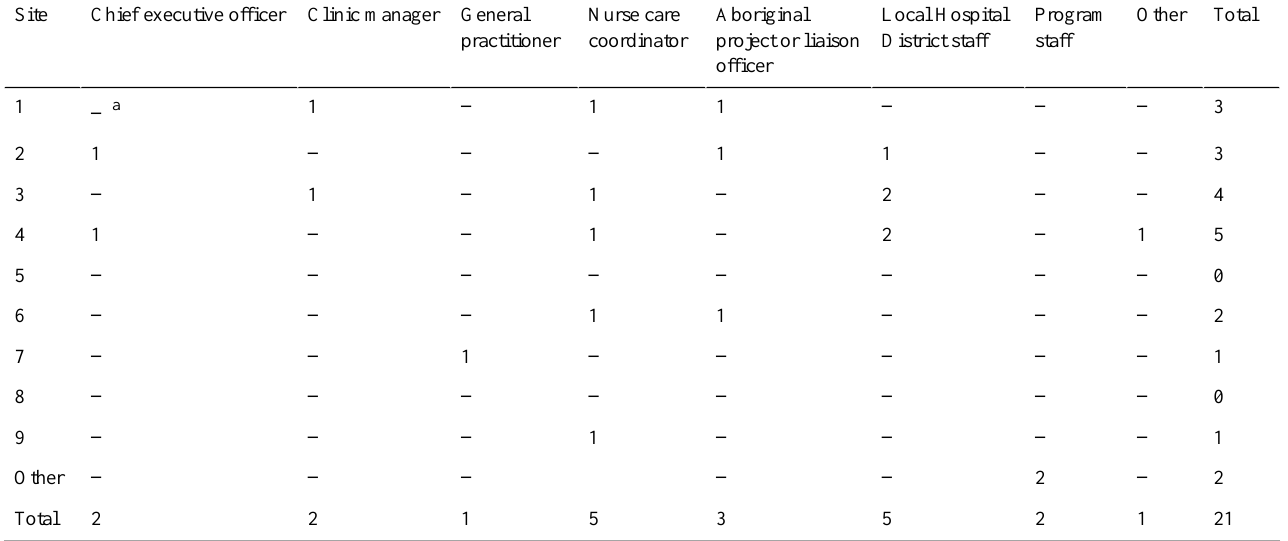
Table 6. Interviews by professional